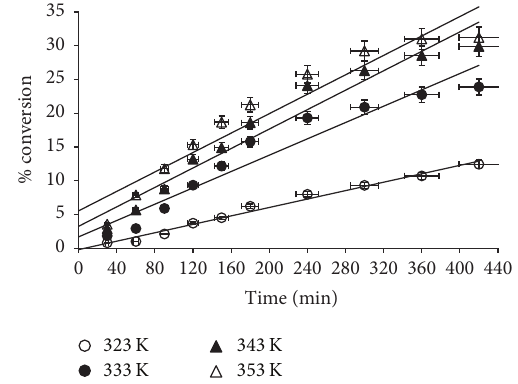
Figure 5: Effect of time for the conversion of cyclohexanol to cyclohexanone at different temperature. Reaction conditions : Cat, 0.1g; cyclohexanol, 10 mL; flow, 40 mL/min; pO 2 , 760 torr; and stirring, 900 rpm.